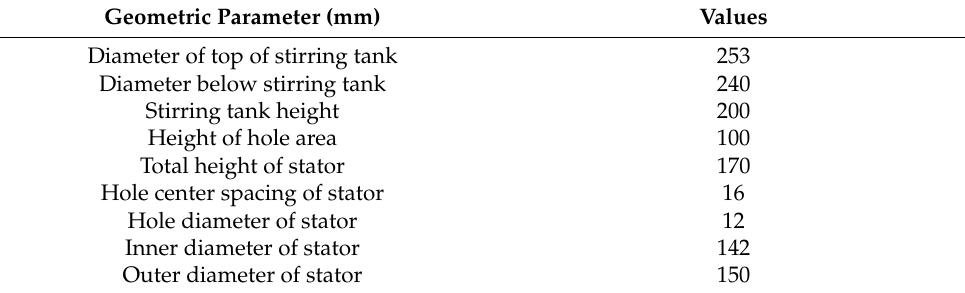
Table 1. Geometric parameters of the stirred tank and agitators.